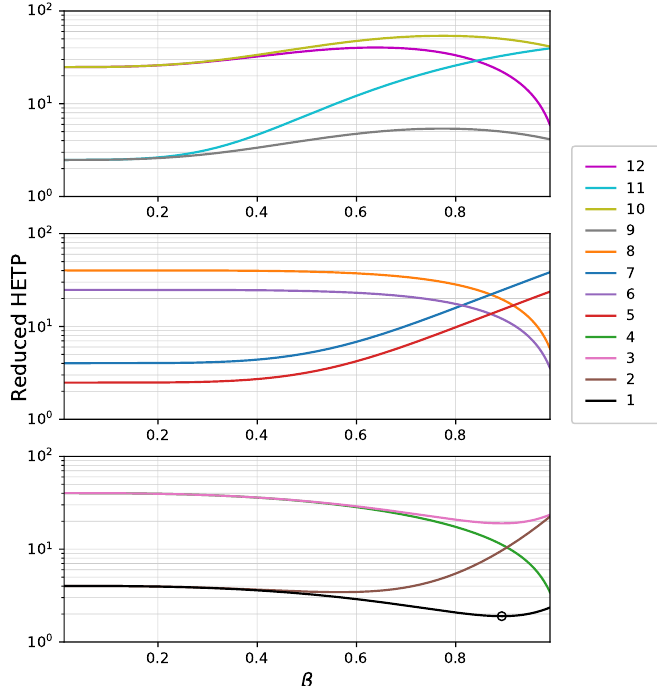
Figure 2. Reduced height equivalent to a theoretical plate (HETP) of totally porous bi-layer particles plotted against β for the scenarios presented in Table2, where β is the factor of proportionality between the radius of the outer surface of the inner porous layer and the particle radius (see Figure1 and Equations (2) and